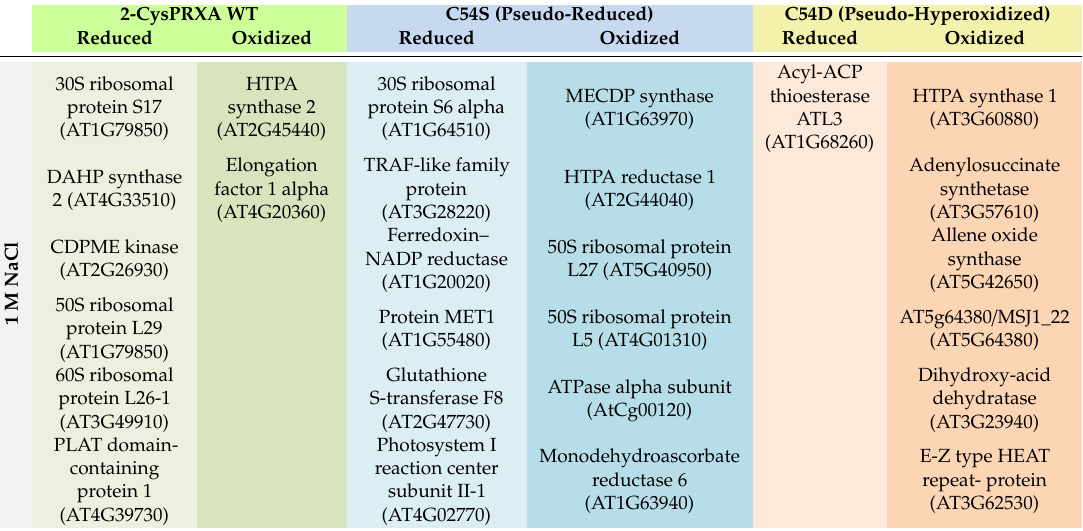
Table 1. Overview of unique proteins eluted under all conditions. WT, wild type; DTT, dithiothreitol. 2-CysPRXA